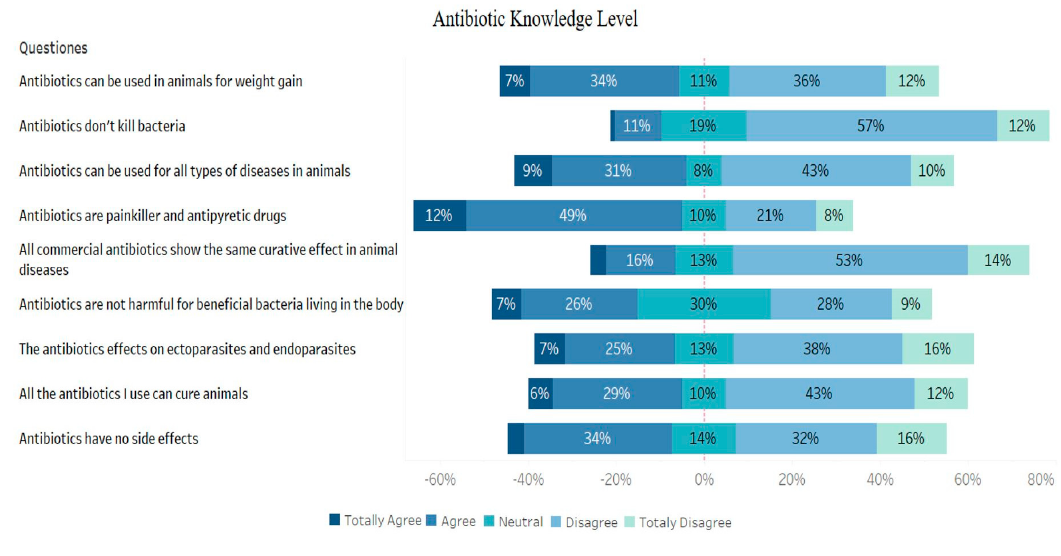
Figure 1. Findings of antibiotic knowledge level.